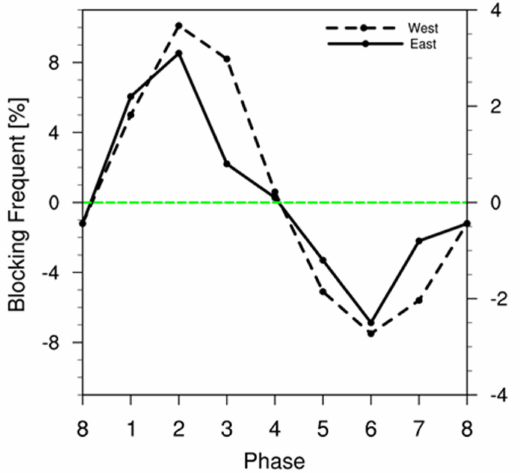
Figure 8. Evolution of Ural blocking frequency anomaly during different phases for the westward- propagating mode (dashed line) and the eastward − propagating mode (solid line); the left (right) vertical axis corresponds to the westward (eastward) − propagating mode; unit: